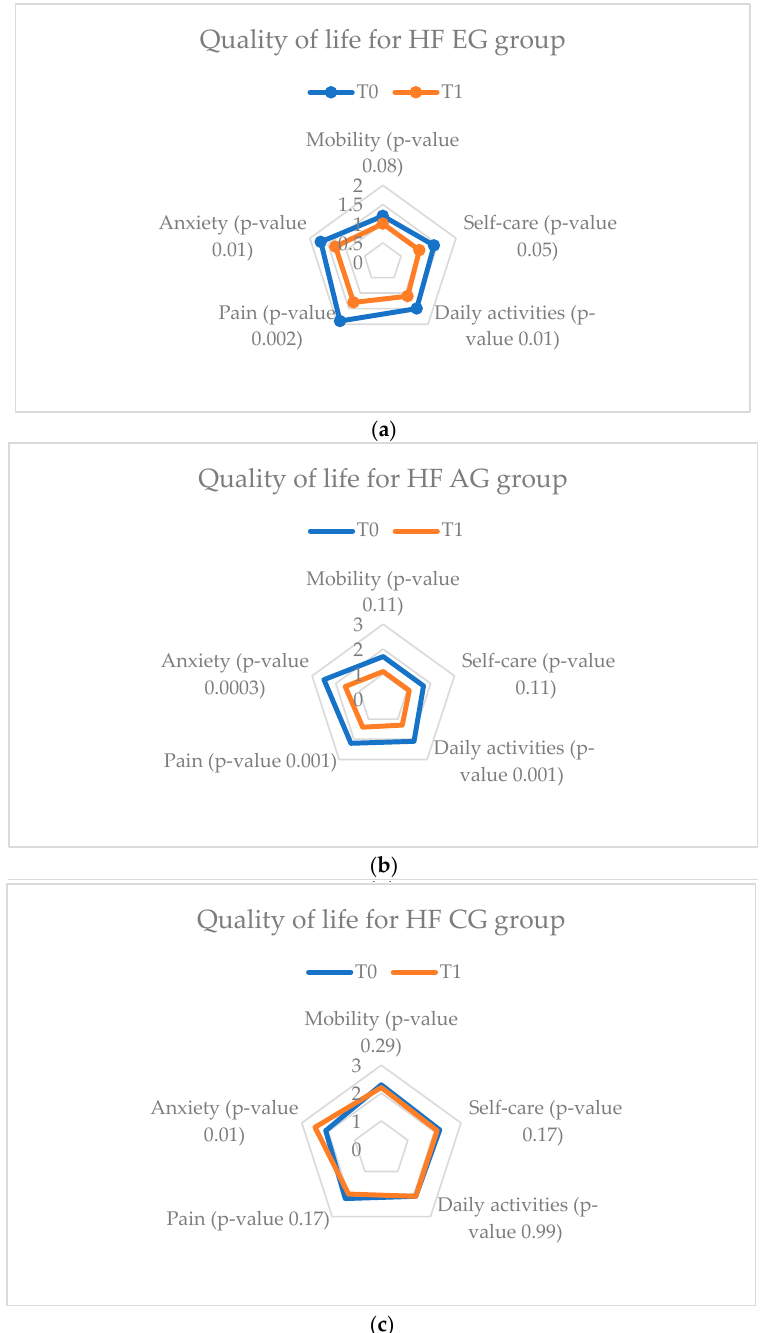
Figure 11. EuroQol-5D results parameters for the heart failure study groups. ( a ) Quality of life for HF EG group. ( b ) Quality of life for HF AG group. ( c ) Quality of life for HF CG group.